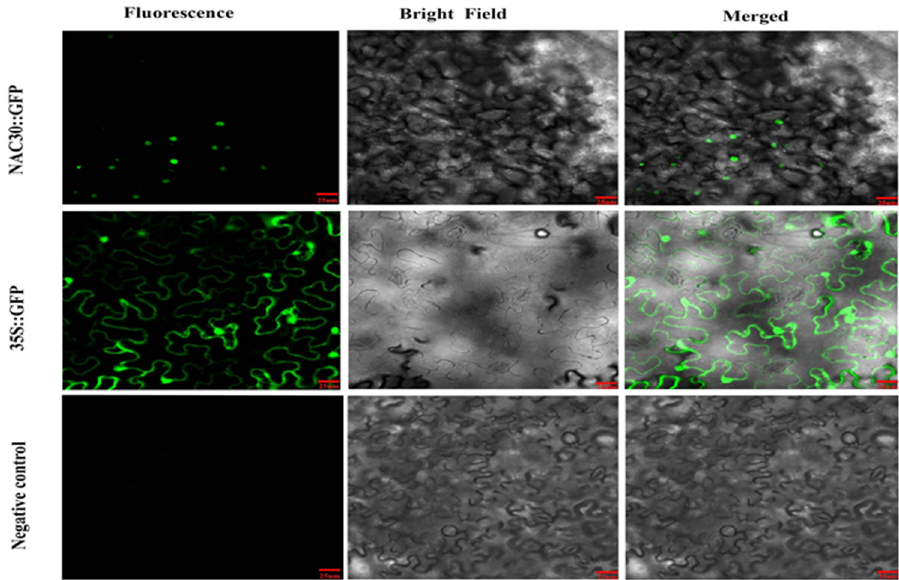
Figure 10. Subcellular localization of AcNAC30 and empty vector in Nicotiana benthamiana leaves after 2 days of infiltration. The green fluorescence of GFP was indicated. White arrows indicated the GFP signal from the nucleus. Scale bars = 25 µ m.